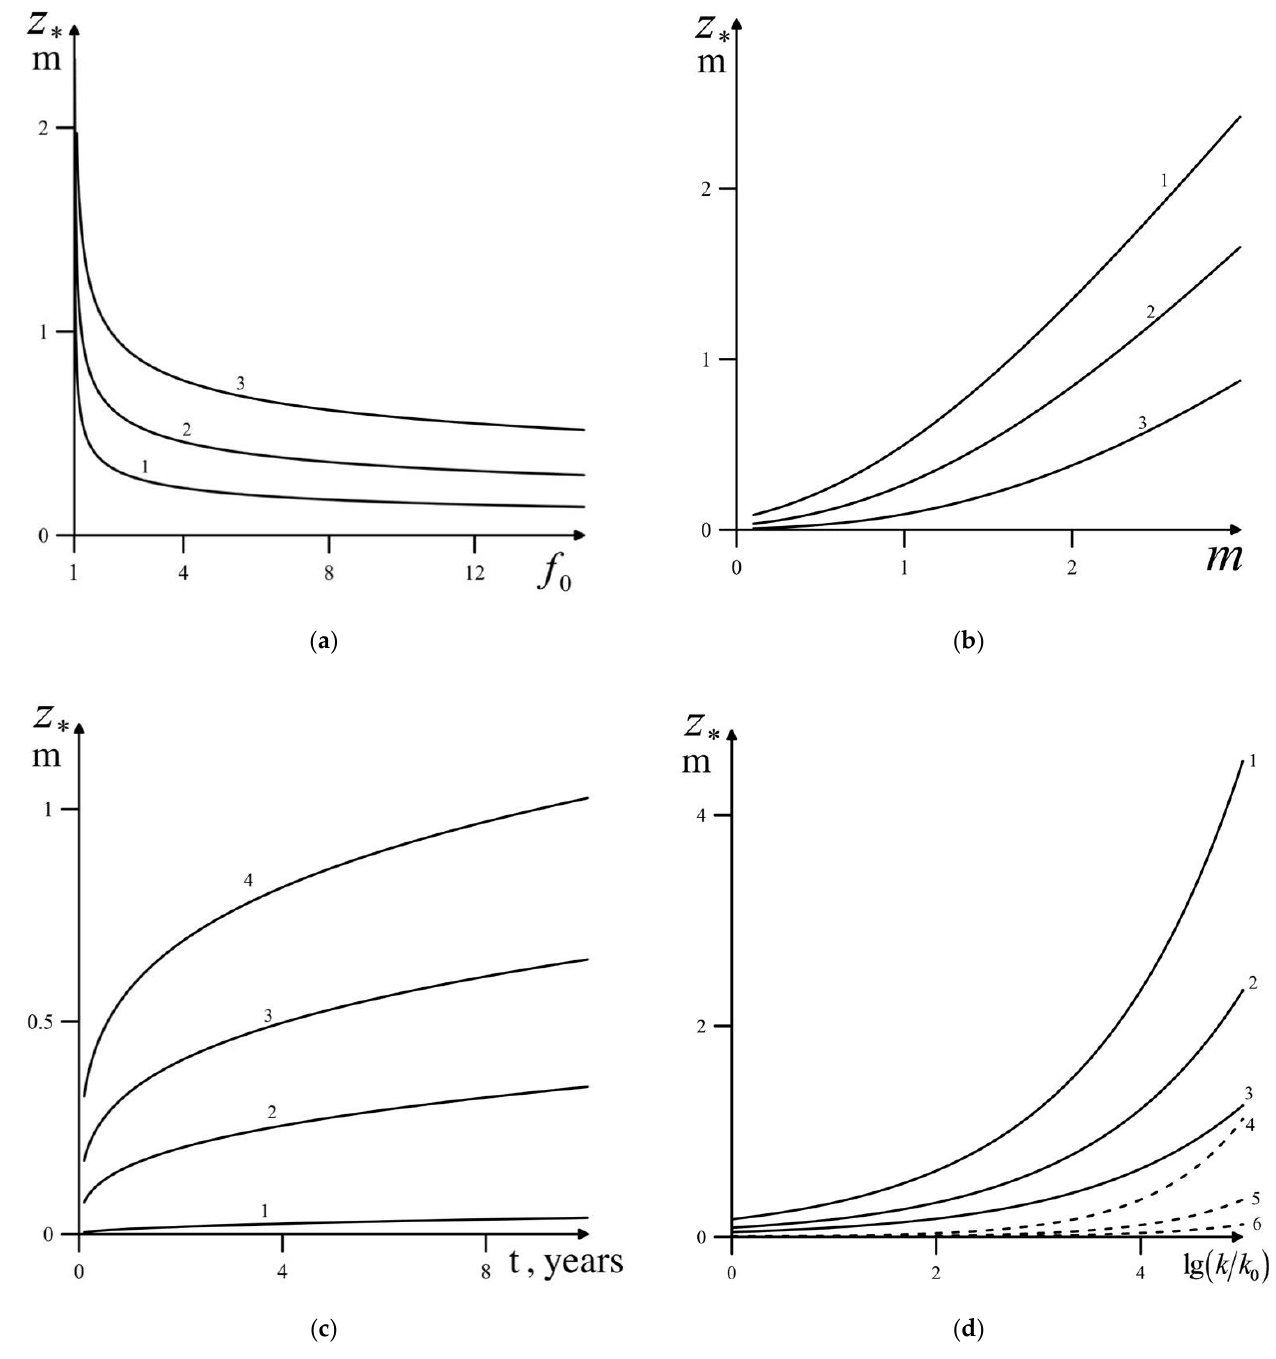
Figure 5. The distance traveled by the phase transition (hydrate decomposition front) boundary in the first year depending on: ( a ) latent pressure at m = 1; 1.5; 2 ( 1 − 3 ) ; ( b ) permeability exponent m at f 0 = 1.3; 3; 50 ( 1 − 3 ) ; ( c ) dynamics of the front movement over 10-year period for f 0 = 10 and m = 1.1; 1.5; 2 ( 1 − 4 ) ; ( d ) front position versus the logarithm of the relative effective